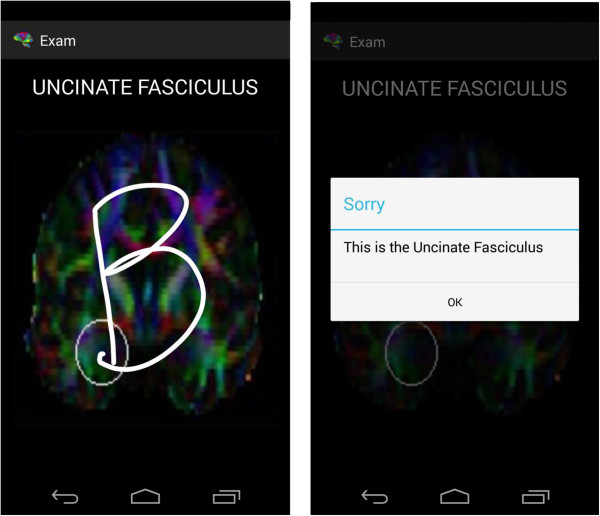
Examination Type 1.